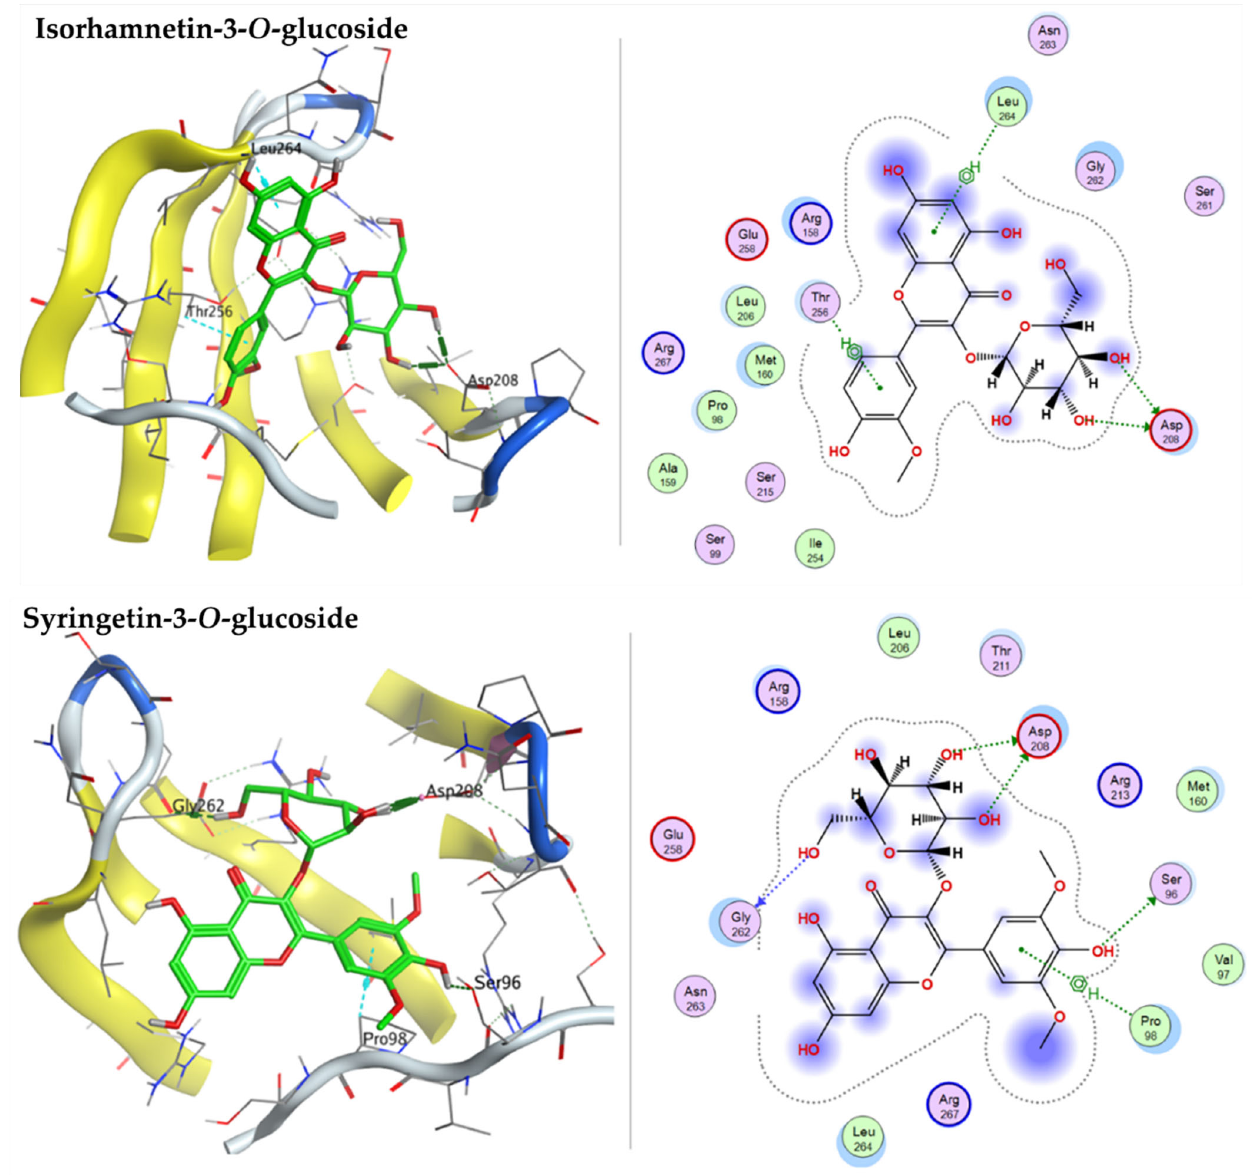
Figure 10. 3D and 2D docking plots of narcissoside (Isorhamnetin ‐ 3 ‐ O ‐ rutinoside), isorhamnetin ‐ 3 ‐ O ‐ glucoside, and syringetin ‐ 3 ‐ O ‐ glucoside, respectively, on P53 (PDB code: